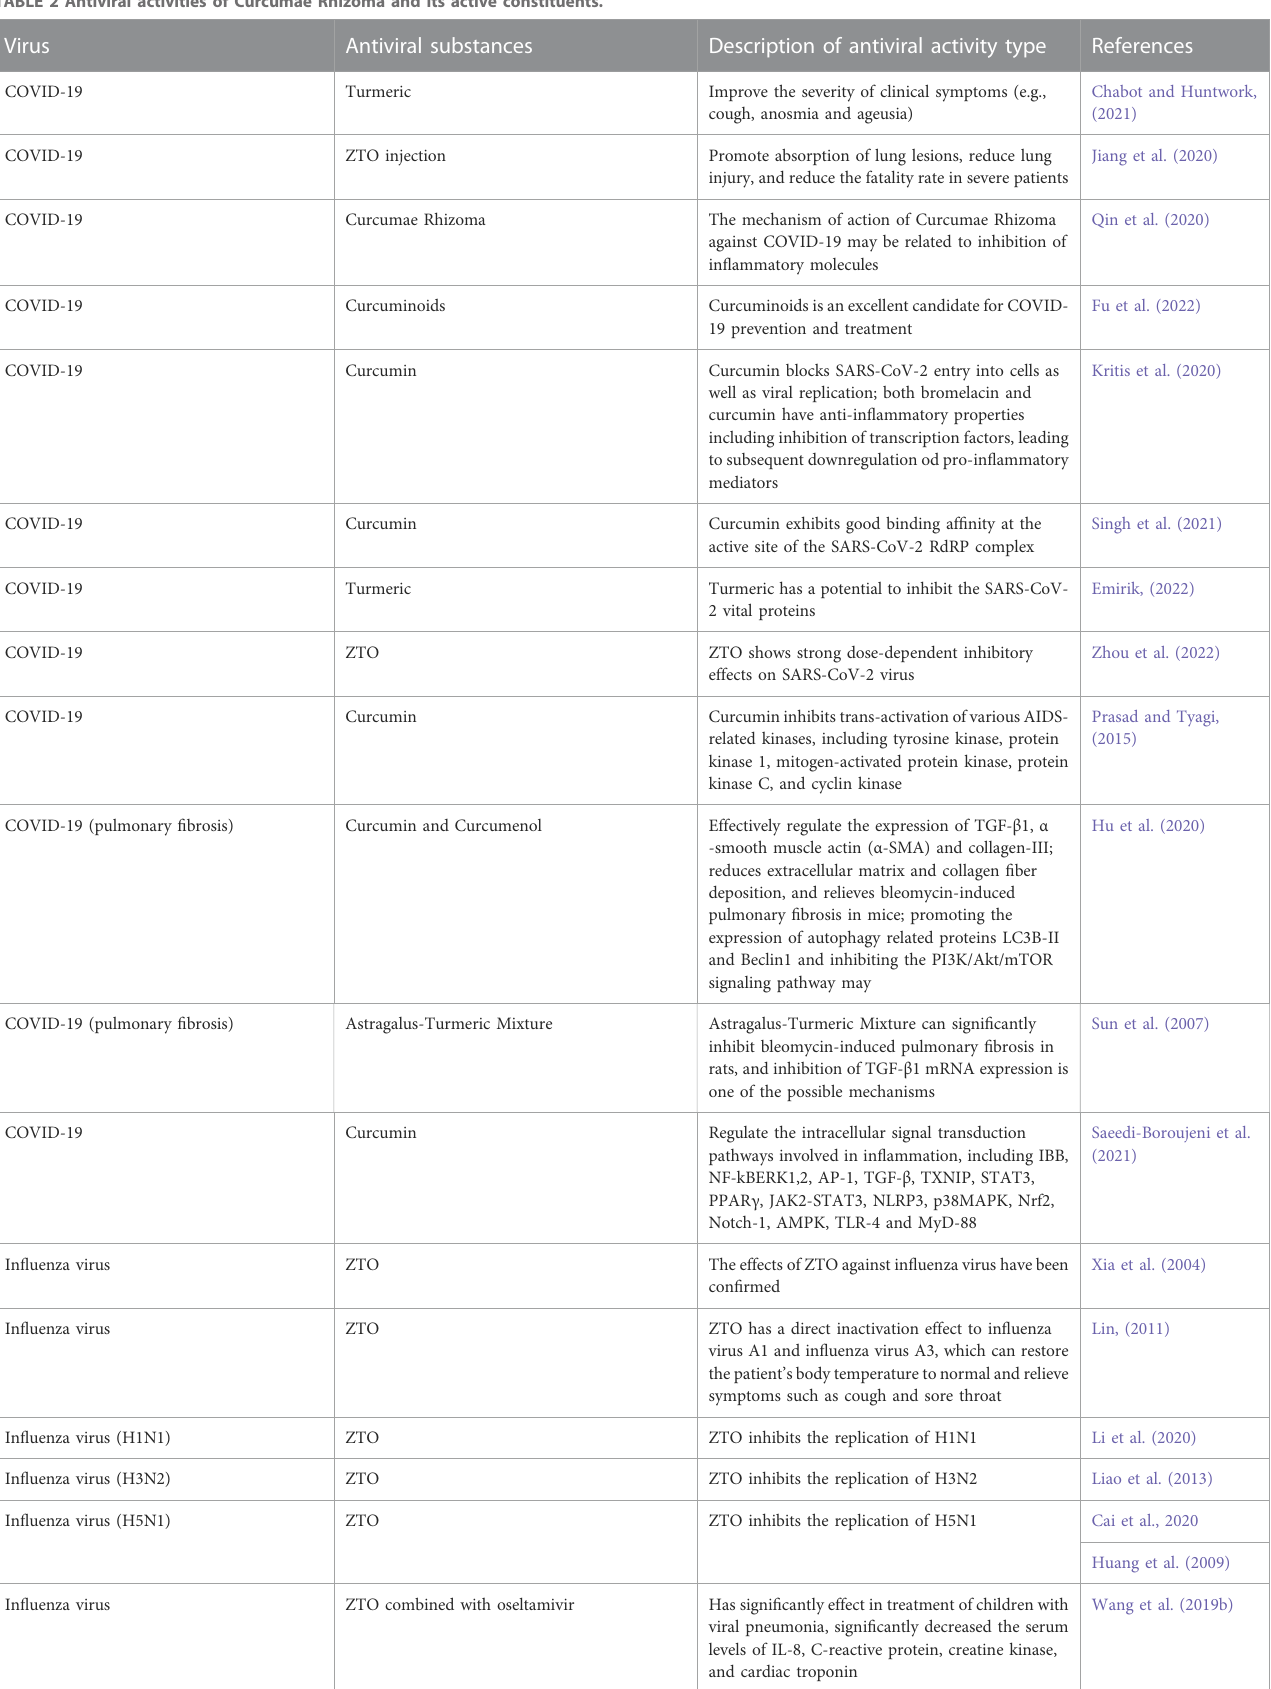
TABLE 2 Antiviral activities of Curcumae Rhizoma and its active